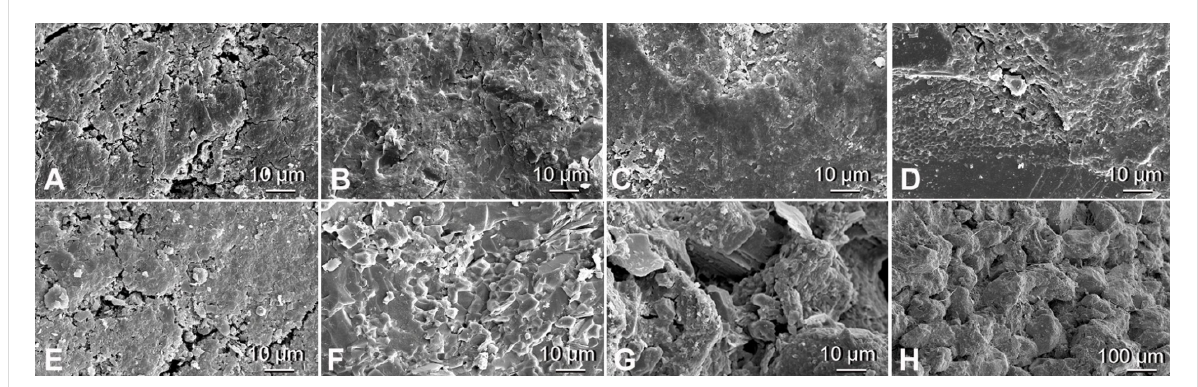
Figure 2: SEM pictures of the surface of selected rocks found in running waters: (A) andesite, (B) slate, (C) basalt, (D) quartz gravel (E) greywacke, (F) quartzite and (G, H) sand stone. (Reproduced from [18]).